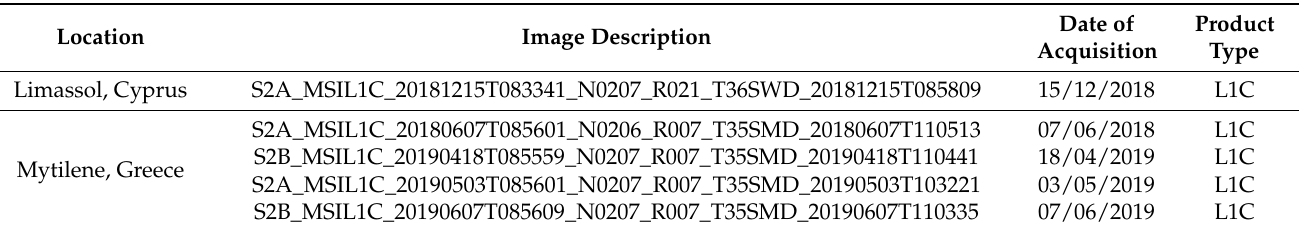
Table 2. Description of the Sentinel-2 images used in the study at two locations along with date of acquisition (dd/mm/yyyy) and product